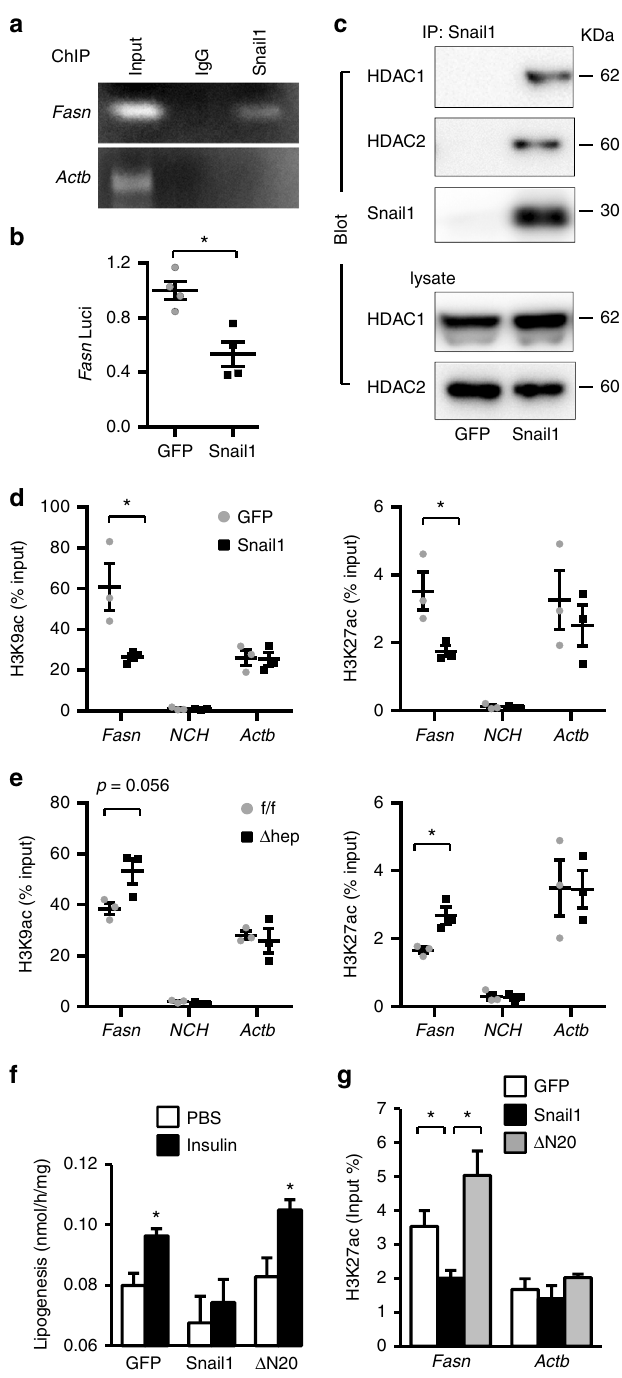
fi ndings demonstrate that insulin concomitantly stimulates both the canonical lipogenic (e.g., Srebp-1c) and the noncanonical Snail1 (anti-lipogenesis) pathways. The noncanonical Snail1 arm likely puts a brake on the canonical lipogenic arm, combating excessive lipogenesis and lipotoxicity. In obesity, the insulin/ Snail1 brake was impaired, likely contributing to increased hepatic lipogenesis and NAFLD. Aside from insulin, Wnts, TGF β 1, and additional factors also upregulate Snail1 18,28,29 . Both Wnt and TGF β 1 suppress lipogenesis 30,31 . Therefore, Snail1 may serve as a common node upon which these factors converge to regulate lipogenesis and intracellular lipid content. It is worth